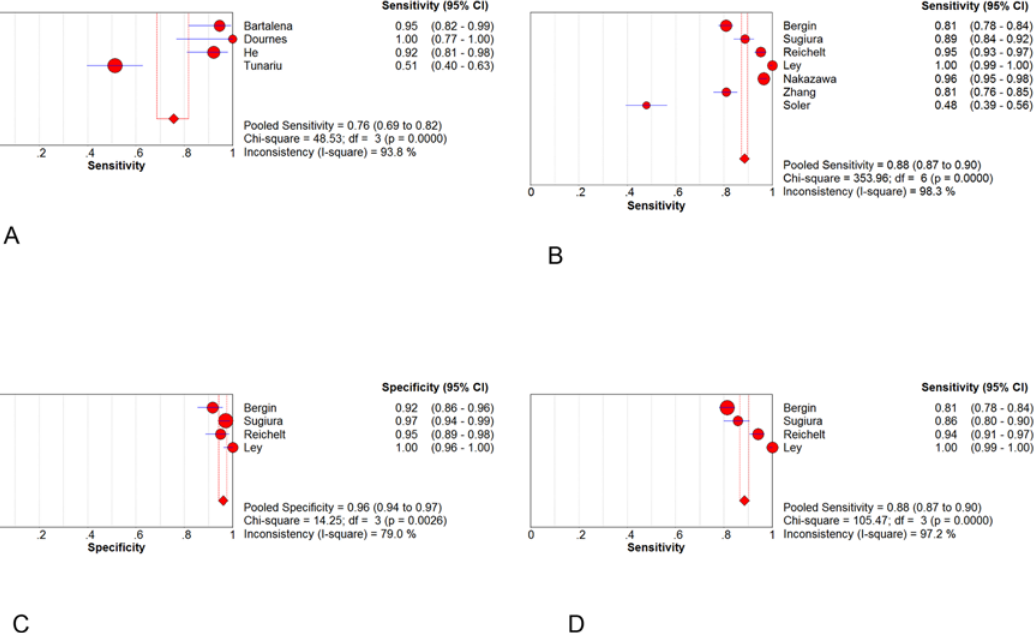
Fig 3. Forest plots of sensitivity. Sensitivity in (A) patient basis; (B) total arteries; (C) main + lobar arteries; (D) segmental arteries.